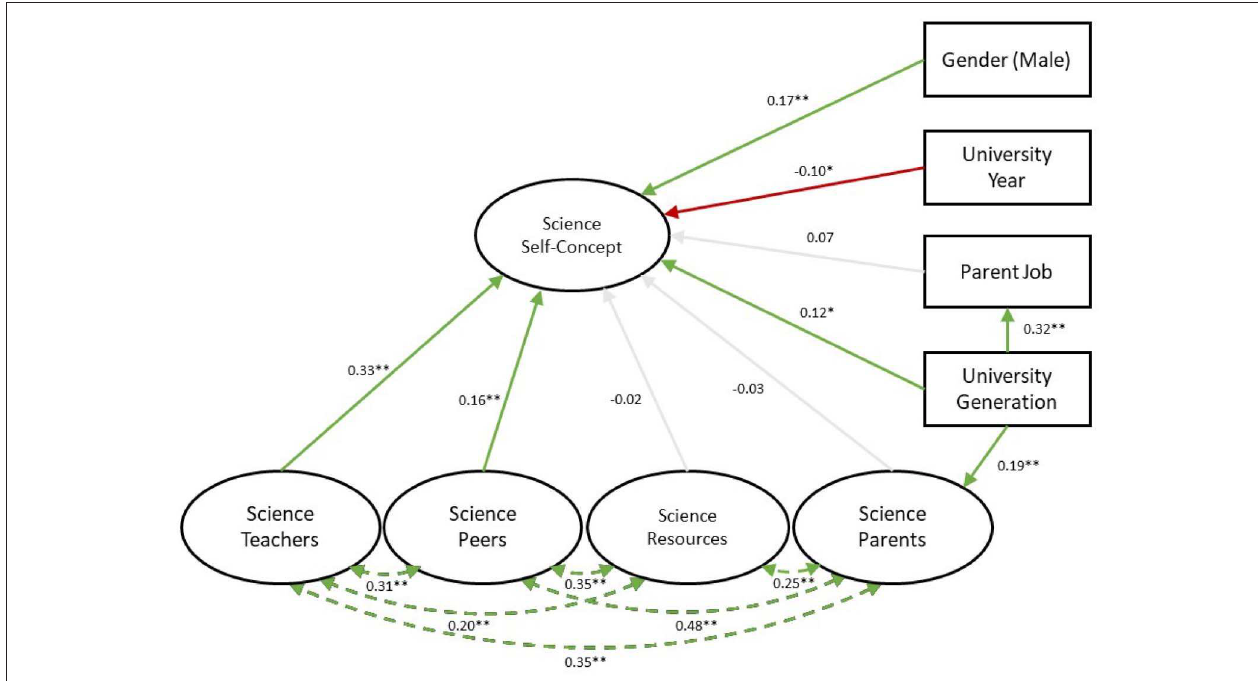
FIGURE 2 | Model results. Results with standardized coefficients and significant of the original conceptual model outlined in Figure 1 . Single headed solid lines indicate a regression, while double headed dotted lines indicate a correlation. Green arrows indicate a positive association, while red indicates a negative association. Faded gray lines indicate no significant relationship. * p < 0.05, ** p <